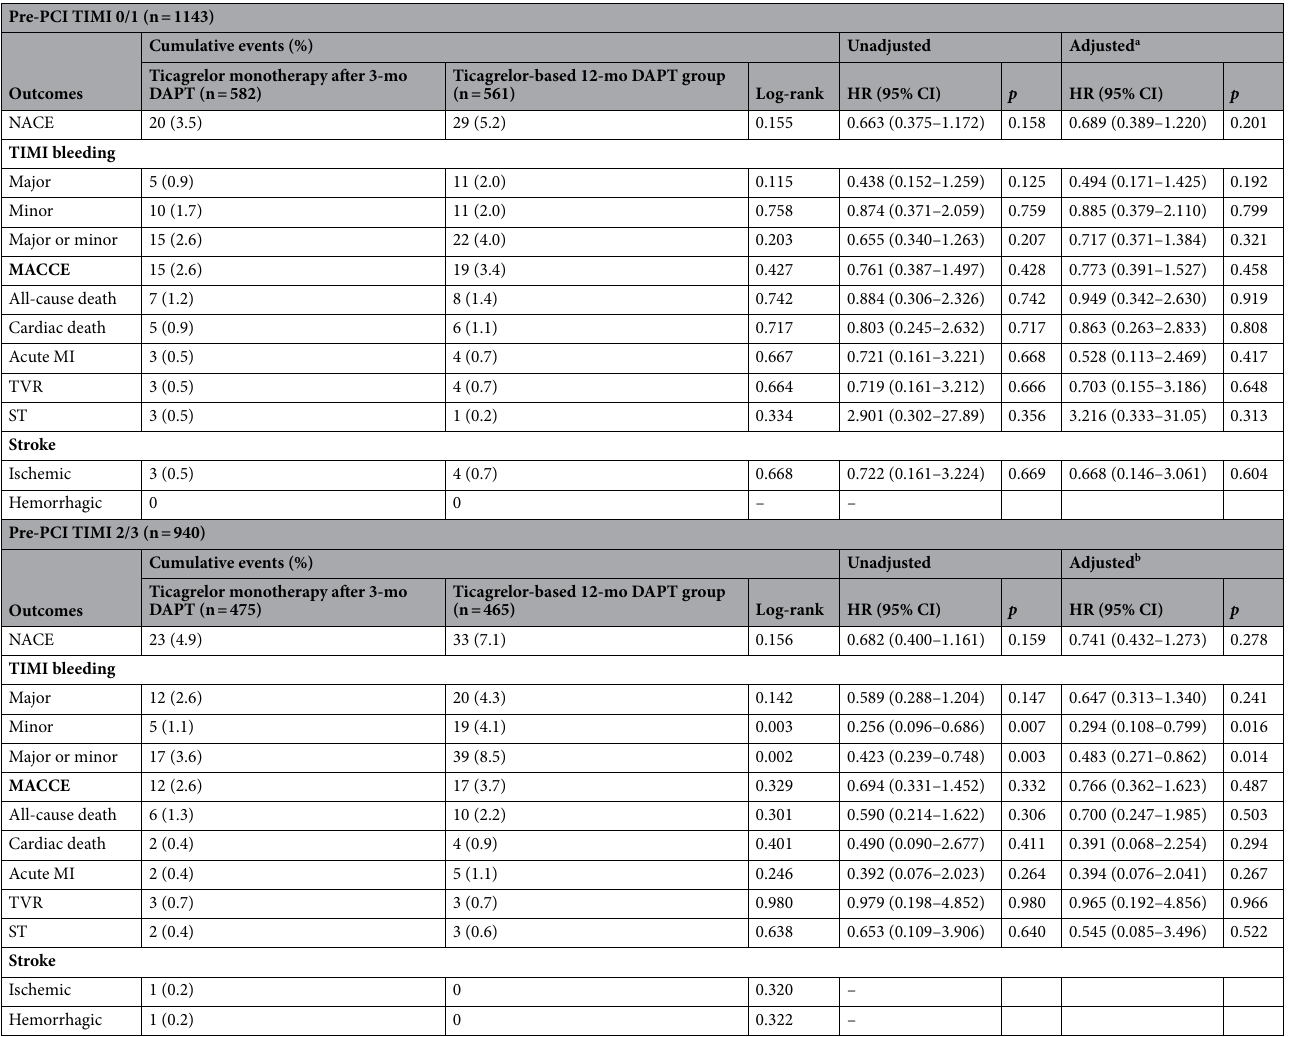
Table 2. Clinical outcomes by Kaplan–Meier analysis and Cox-proportional hazard ratio analysis at 1 year. Pre-PCI pre-percutaneous coronary intervention, TIMI Thrombolysis In Myocardial Infarction, DAPT dual antiplatelet therapy, HR hazard ratio, CI confidence interval, NACE net adverse clinical events, MACCE major adverse cardiac and cerebrovascular events, MI myocardial infarction, TVR target vessel revascularization, ST stent thrombosis, eGFR estimated glomerular filtration rate, LVEF left ventricular ejection fraction, STEMI ST-segment elevation myocardial infarction. a Adjusted by age, prior MI, serum creatinine, eGFR, and stent diameter (Supplementary material 15). b Adjusted by age, male, LVEF, hypertension, diabetes mellitus, prior PCI, serum creatinine, and eGFR (Supplementary material